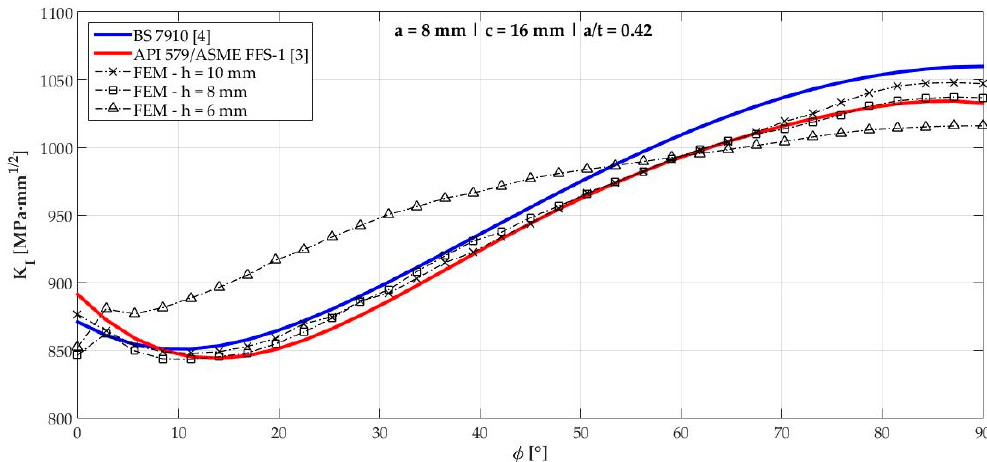
Figure 7. Mode I SIF profiles for crack 2 ( a = 8 mm , c = 16 mm , and a/t = 0.42 ).